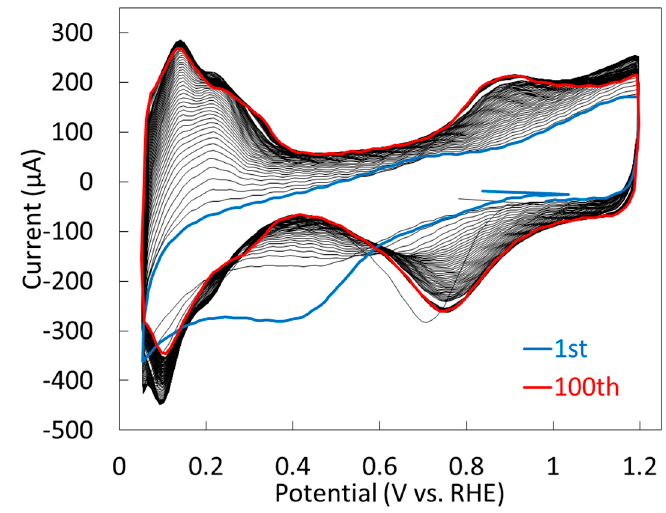
Figure 7. Cyclic voltammograms during activation potential cycles. 1st and 100th cycles are highlighted.